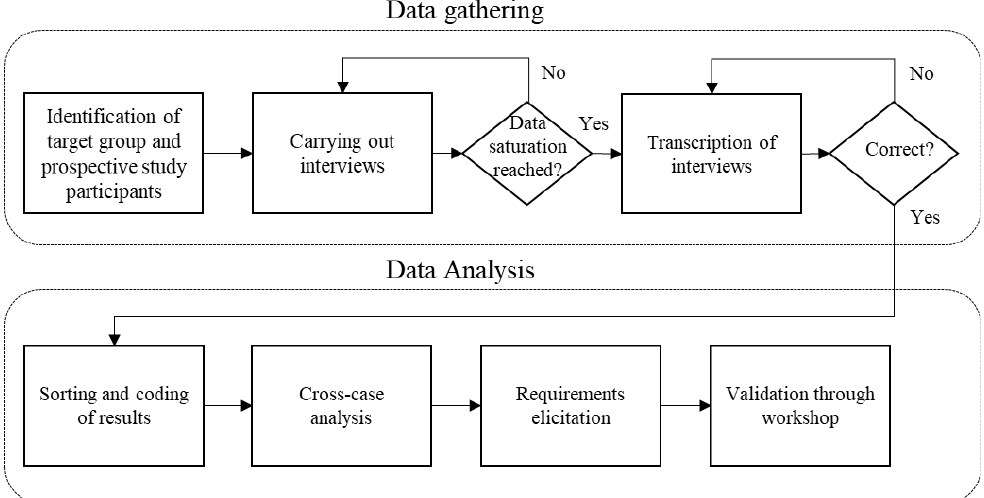
Figure 1. Study design.